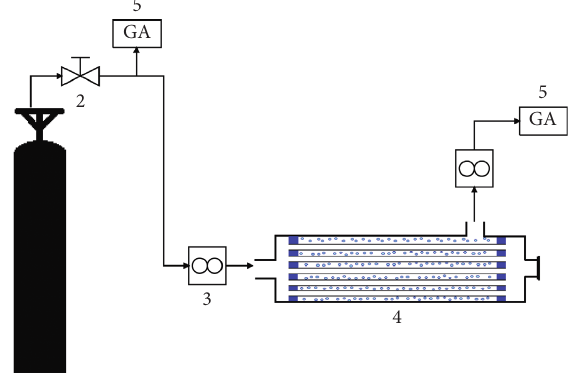
Figure 1: Schematic diagram of NOx removal experiment: 1. feed gas tank; 2. valve regulator; 3. mass flow controller; 4. hollow fiber membrane module; 5. gas